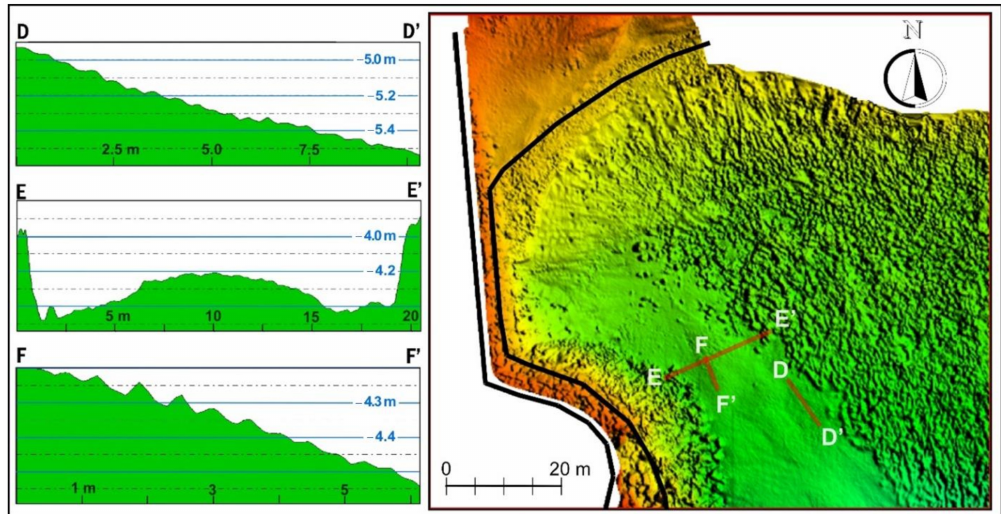
Figure 16. Zoom of the eastern sector of the study area (for location, see Figure 15): the red lines indicate the location of sections shown in the left